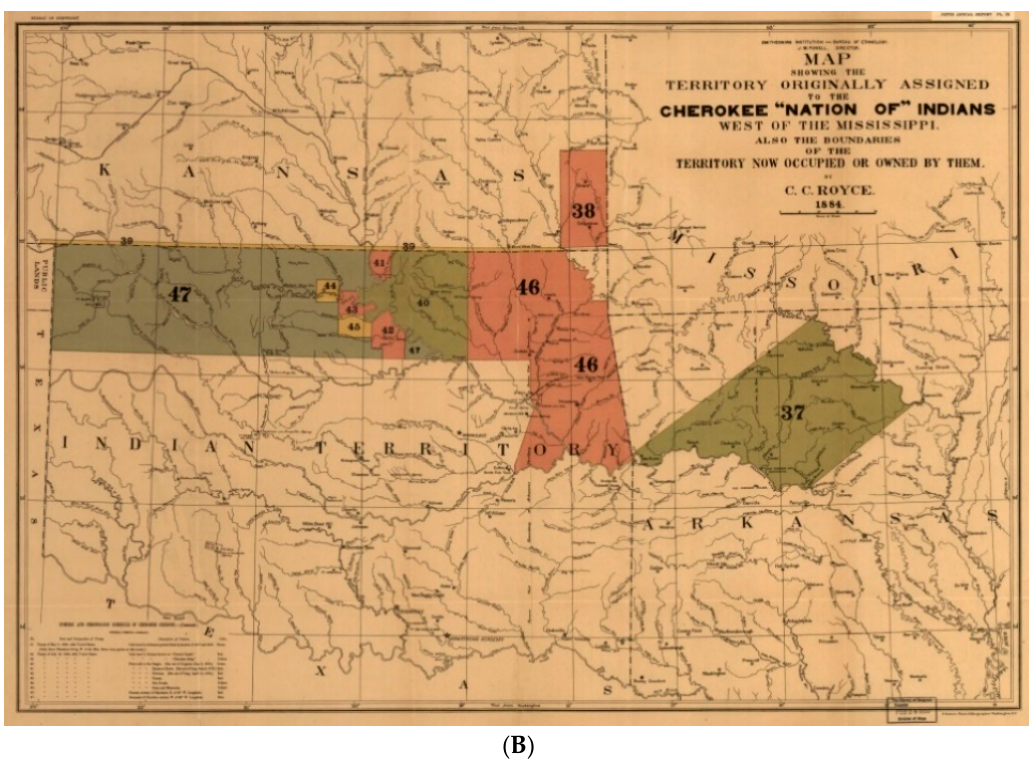
Figure 1. Cherokee territorial lands [26]. ( A ) ′′ Map of the former territorial limits of the Cherokee ′ Nation of ′ Indians ′′ , i.e., prior to displacement of Euro-Americans. ( B ) ′′ Map showing the territory originally assigned Cherokee ′ Nation of ′ Indians ′′ , i.e., after the forcible relocation known as the ′′ Trail of Tears”.